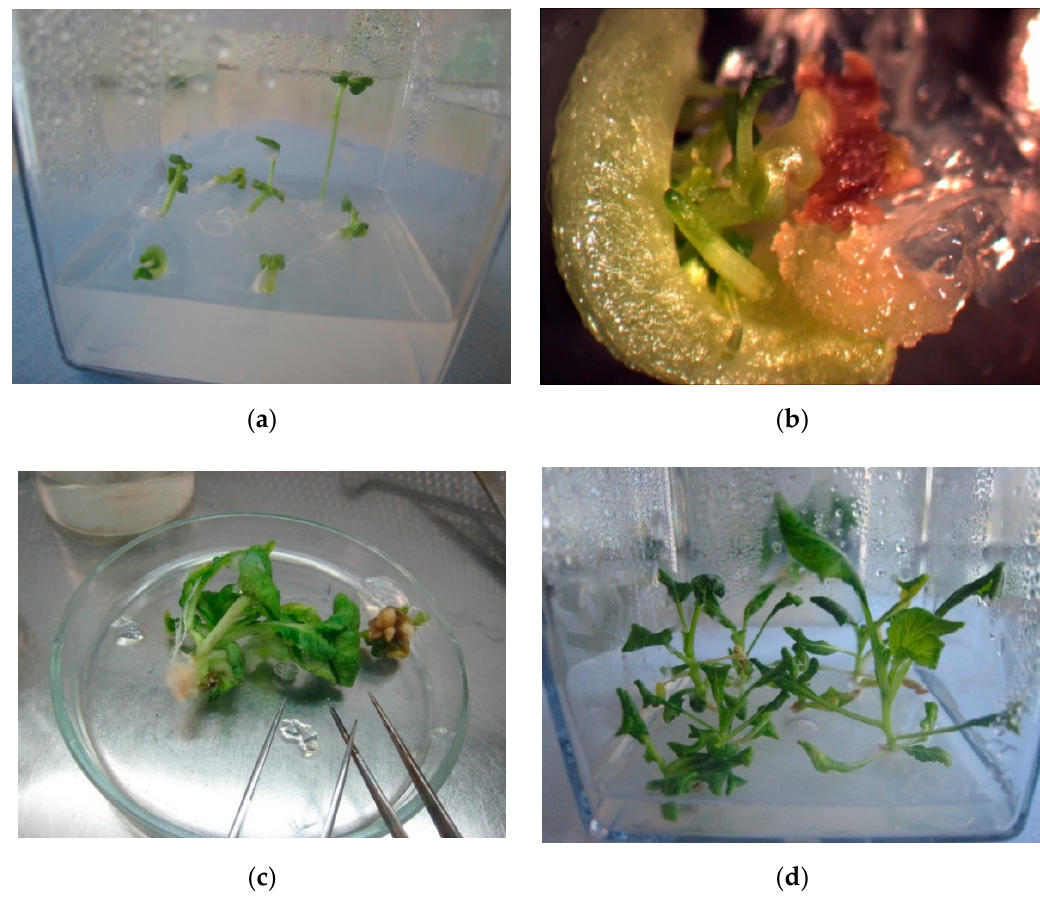
Figure 4. Embryo development into regenerated plantlets: ( a ) Plant regeneration directly from microspore-derived embryos on culture medium without plant growth regulators; ( b ) secondary embryos development from microspore-derived embryos on culture medium supplemented with 1 mg/L benzylaminopurine (BAP) and 0.05 mg/L gibberellic acid (GA); ( c ) cutting off the plantlets from the explant (microspore-derived embryo); and ( d ) plantlets rooting. Table 4. Ploidy level of plantlets obtained from primary microspore-derived embryos and secondary turnip embryos.